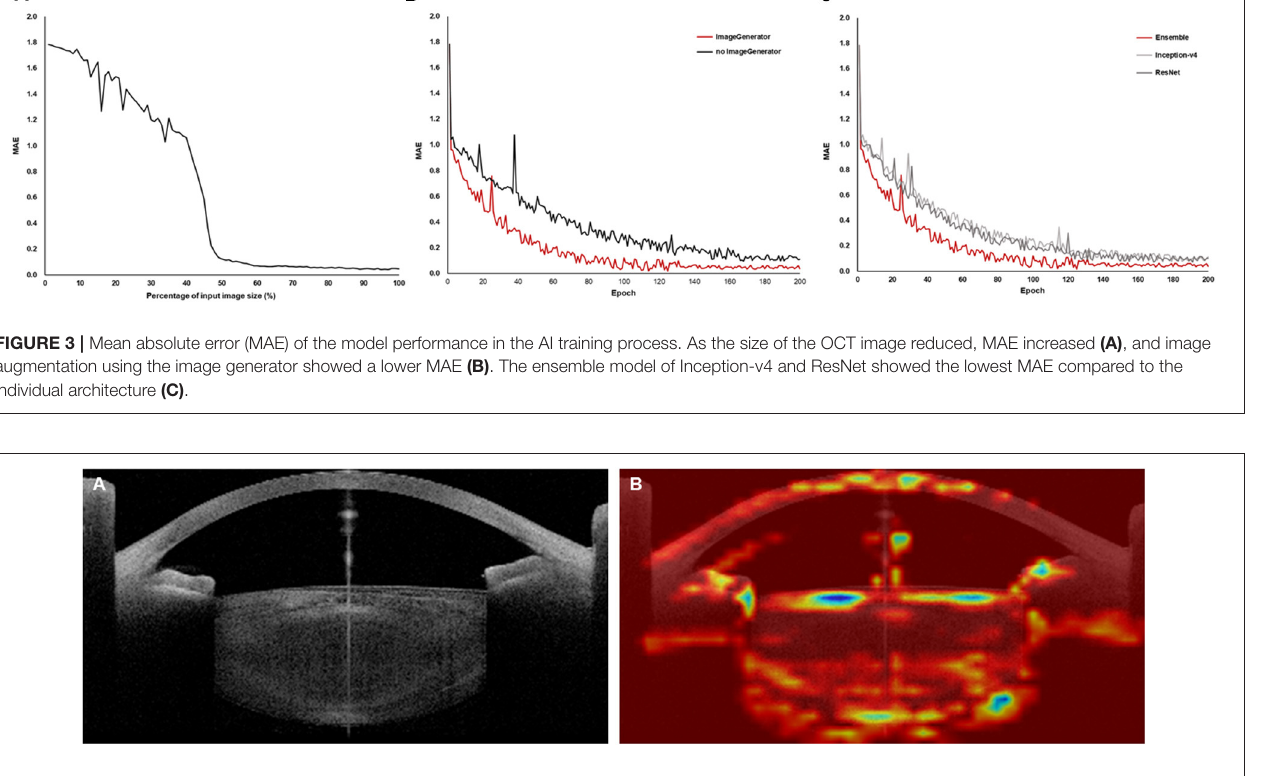
FIGURE 4 | Example of heatmap analysis of the Artificial Intelligence (AI) attention area. Original OCT image (A) and Heatmap image (B) . The preoperative best-corrected visual acuity (BCVA) of this 67-year-old patient, who showed a senile cataract with grade 3 cortical opacity and grade 2 nuclear opacity in the Lens Opacities Classification System III, was 0.50 logMAR, and the AI-estimated BCVA was 0.52